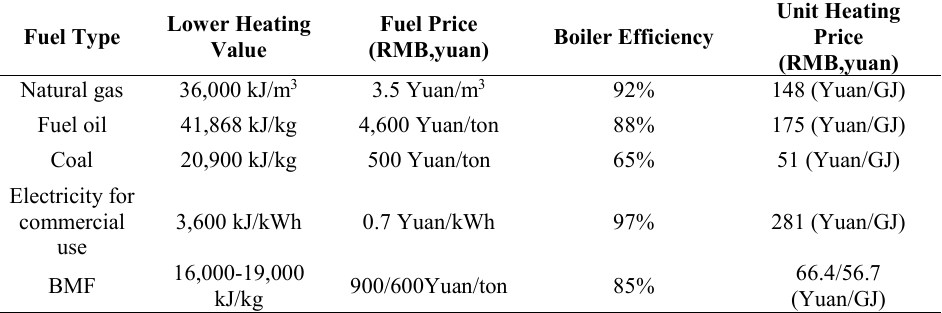
Table 1. Economic comparison between BMF and other sources for heat production.